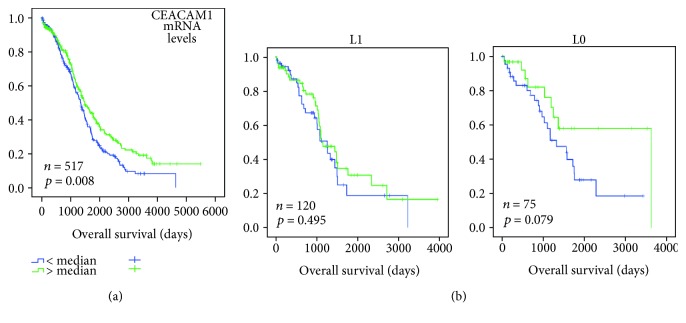
CEACAM1 mRNA levels in ovarian carcinomas (TCGA cohort). (a) Kaplan–Meier analysis showing a significant correlation of high CEACAM1 mRNA levels with longer overall survival. (b) Kaplan–Meier analysis and log-rank tests stratified for tumors with (L1) and without (L0) lymphovascular invasion. High CEACAM1 mRNA levels showed a clear association (p = 0.079) with shorter overall survival only in patients without lymphovascular invasion (L0) in comparison with those with lymphovascular invasion (L1).